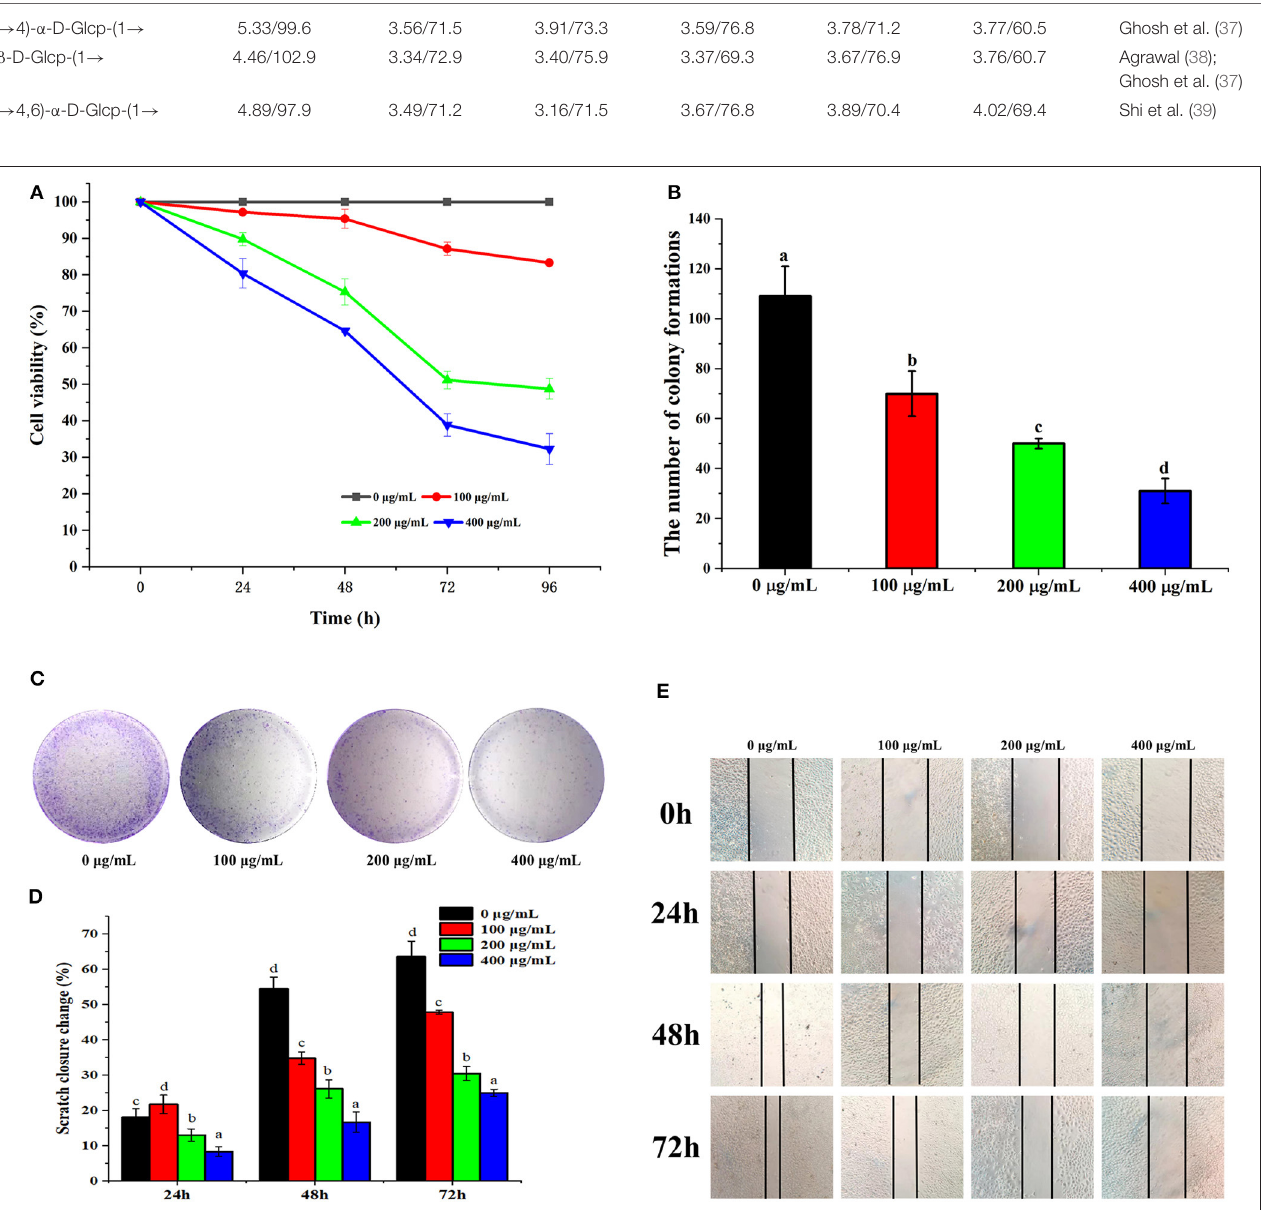
FIGURE 4 | PSP-1 inhibits HepG2 cells proliferation in vitro . HepG2 cells were treated with different concentration (0, 100, 200, 400 µ g/mL) of PSP-1 for 0, 24, 48, 72, and 96h. The effect of PSP-1 on cell proliferation was evaluated by MTT assay. (A) The clonogenicity of the indicated cells were detected after treatment with different concentration of PSP-1. (B,C) Scratch image and scratch closure change of HepG2 cells after treatment with different concentration of PSP-1 (D,E) . Data are presented as the mean ± SD, n = 3. Different letters above the bars indicate significant